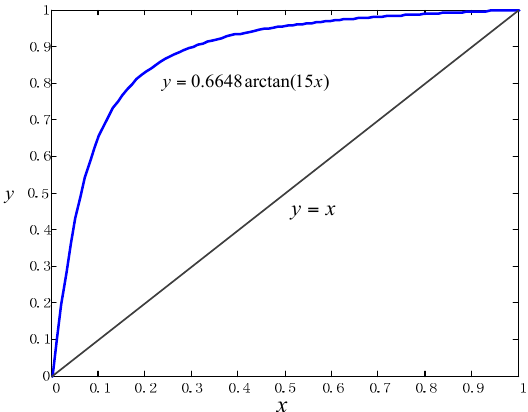
Figure 10. The chosen rewarding function for particle weight updating.